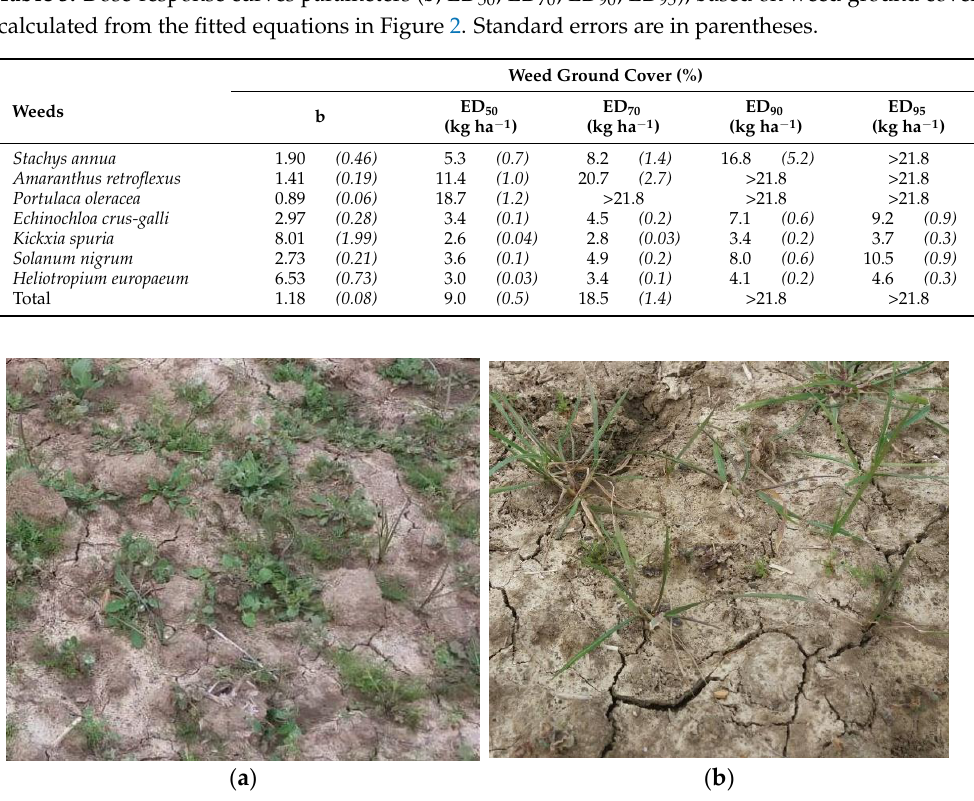
Figure 4. Weeds in the winter experimental plots at 4 WAT: ( a ) untreated control; and ( b ) pelargonic acid at maximum dose (21.8 kg a.i. ha −1 , see the less susceptible weeds: L. multiflorum and M. chamomilla ).